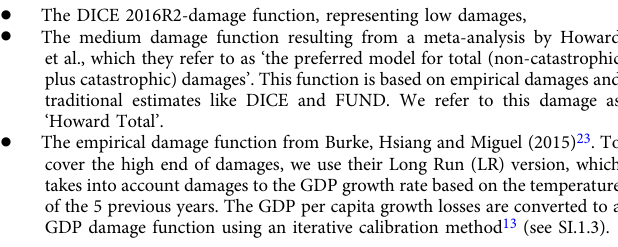
Fig. 1. First, the socio-economic variables like population, total factor productivity and baseline emissions intensity are obtained from the SSPs (blue) 20 . The damage functions (green) cover the current literature range by choosing a low, medium and high damage function (see SI.1.3): ● The DICE 2016R2-damage function, representing low damages, ● The medium damage function resulting from a meta-analysis by Howard et al., which they refer to as ‘ the preferred model for total (non-catastrophic plus catastrophic) damages ’ . This function is based on empirical damages and traditional estimates like DICE and FUND. We refer to this damage as ‘ Howard Total ’ .